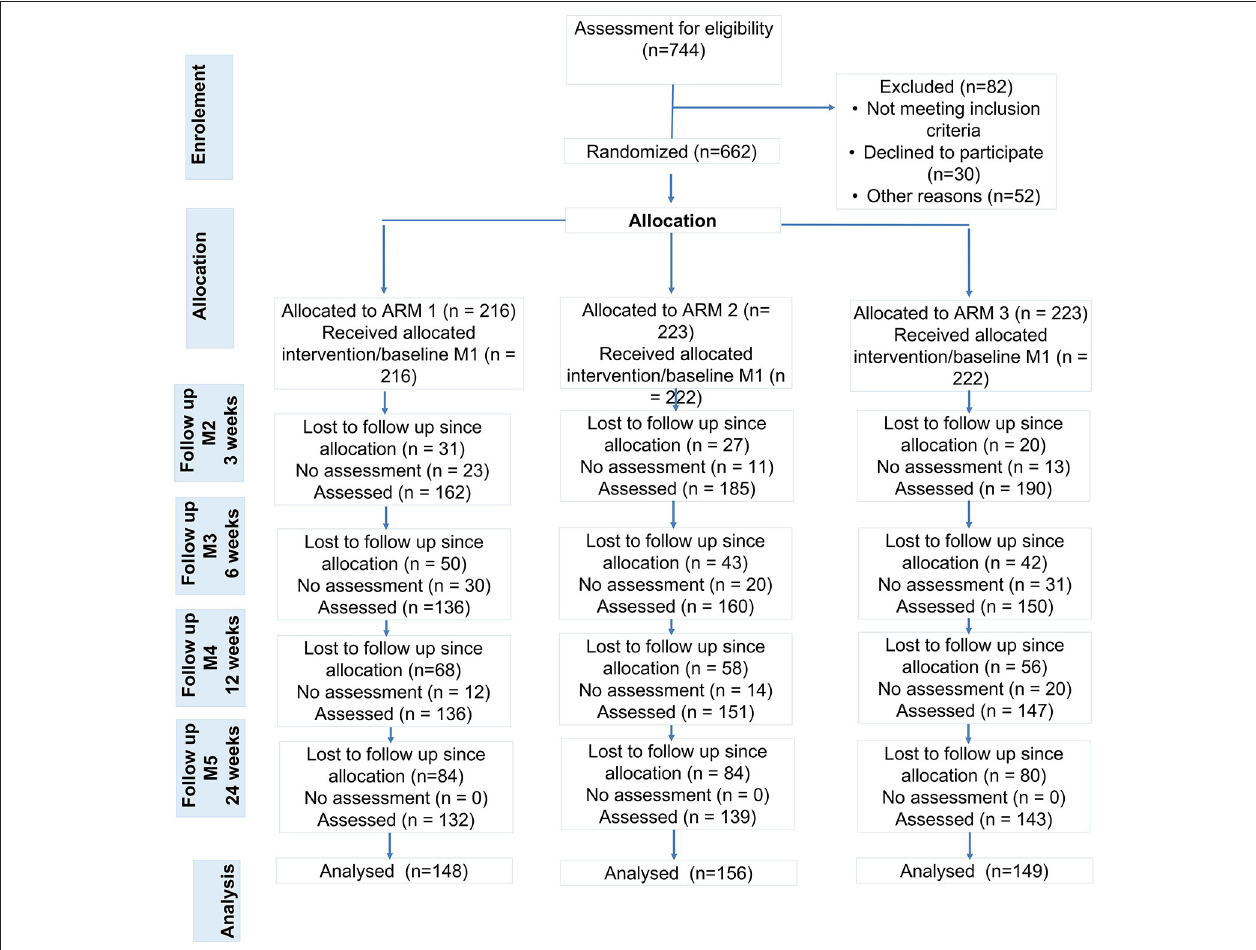
FIGURE 2 | Study Flow (ARM 1: control group, ARM2: unimodal sensorimotor treatment, SMT; ARM 3: multidisciplinary sensorimotor exercise and behavioral treatment, SMT-BT). People with no pain (pain class 0, n = 41), athletes ( n = 11) and people with missing cases at M1, M4 and M5 were excluded from analyses.